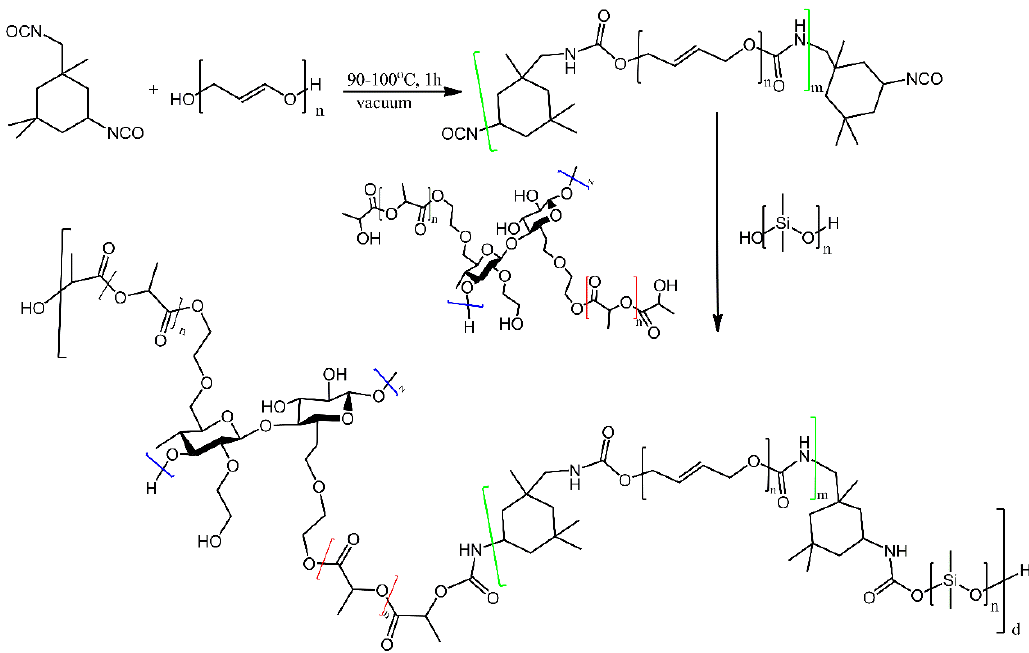
Figure 17. Schematic route of copolymerysation of PDMS based polyurethane. The different types of polymeric fragments are highlighted in colour for clarity. Based on Ref. [41].